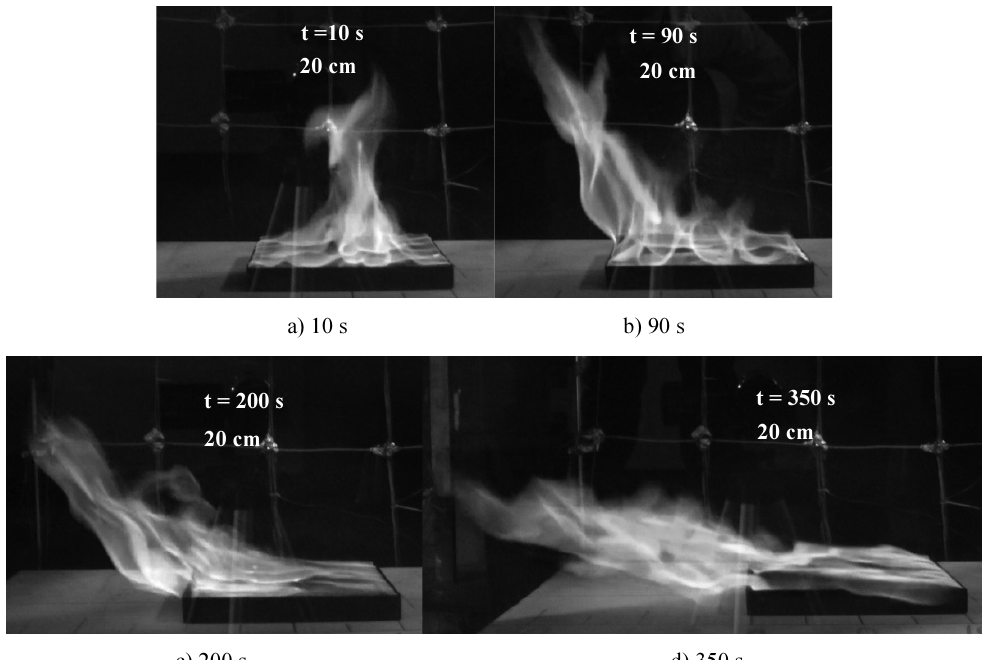
Fig. 3. Flame shape at different time of Case B3 (Top Vent open, Door 3 Size: 0.6 m×0.4 m)